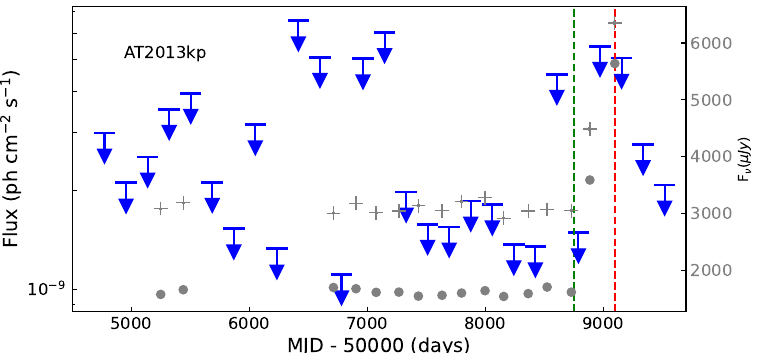
Figure 2. Lightcurves of AT2013kp for Fermi -LAT (left axis, blue data) and for WISE (right axis, grey data). The grey crosses and circles are the lightcurves at band of W1 (3.4 µ m) and W2 (4.6 µ m), respectively. The vertical dashed lines are defined as in Figure 1.